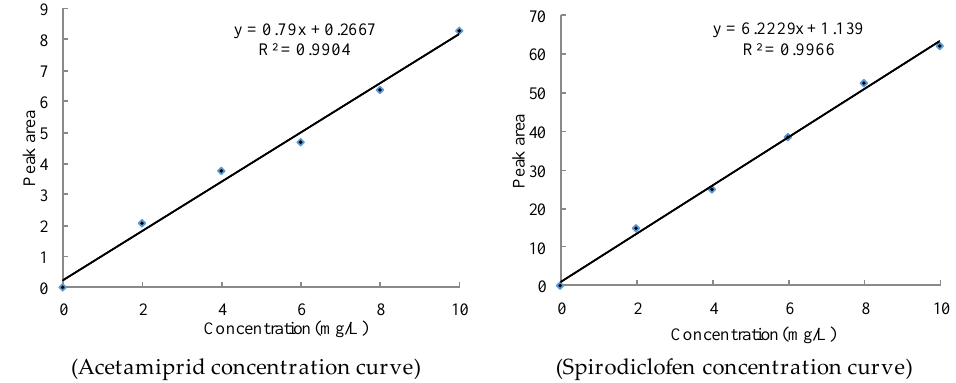
Figure 4. Standard curve of Spirodiclofen and Acetamiprid Concentration.